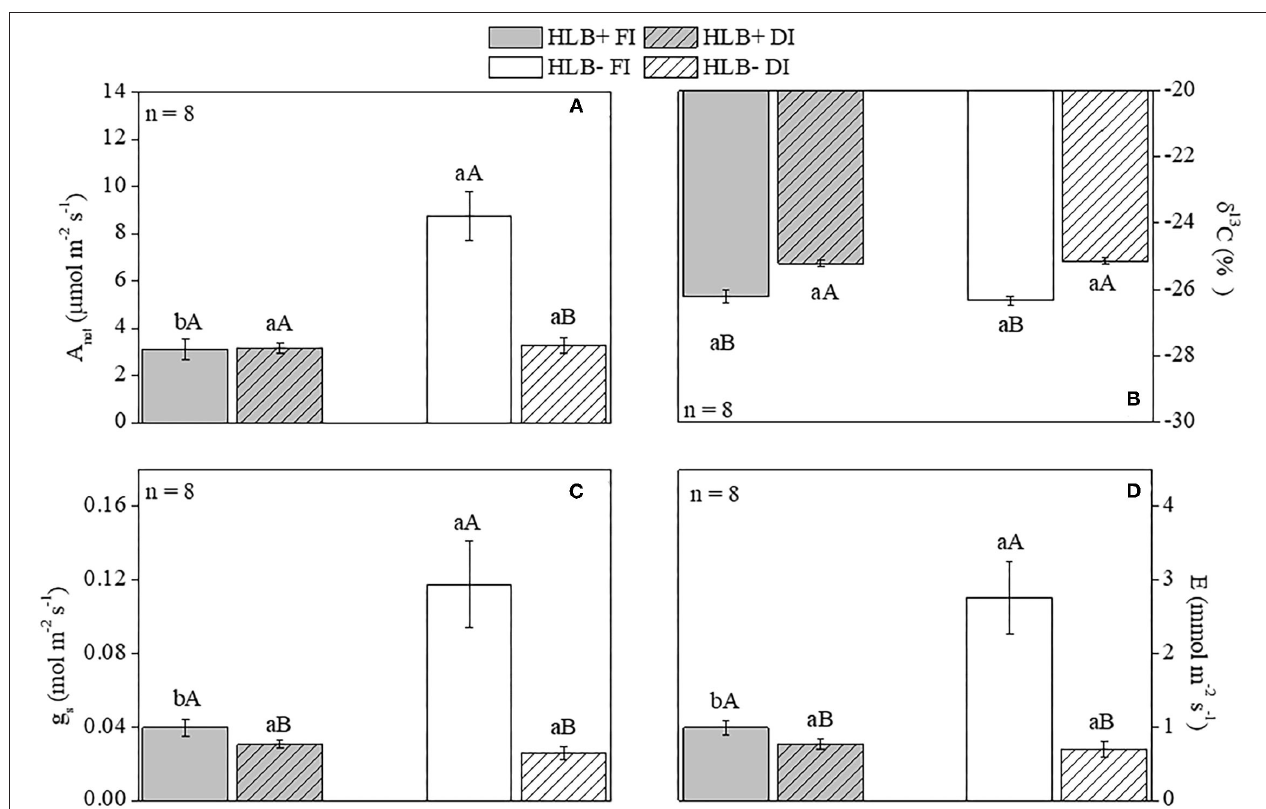
FIGURE 3 | Net photosynthetic rate [ A net , (A) ], carbon isotope composition [ δ 13 C , (B) ], stomatal conductance [ g s , (C) ], and transpiration [ E , (D) ] of leaves of “Valência” orange trees [ Citrus sinensis (L.) Osbeck] grafted on citrumelo “Swingle” rootstock [ Citrus paradisi Macfad. x Poncirus trifoliata (L.) Raf.] either infected with “ Ca . Liberibacter asiaticus” ( + ) or healthy (–) and exposed to two water management treatments fully irrigated (FI) and deficit-irrigated (DI). Values are mean ± SE ( n = 8). Means followed by the same letter do not differ between water management treatments within the same HLB infection condition (upper case) or between HLB infection conditions within the same water management treatment (lower case) according to unpaired Student’s t -test at 5%